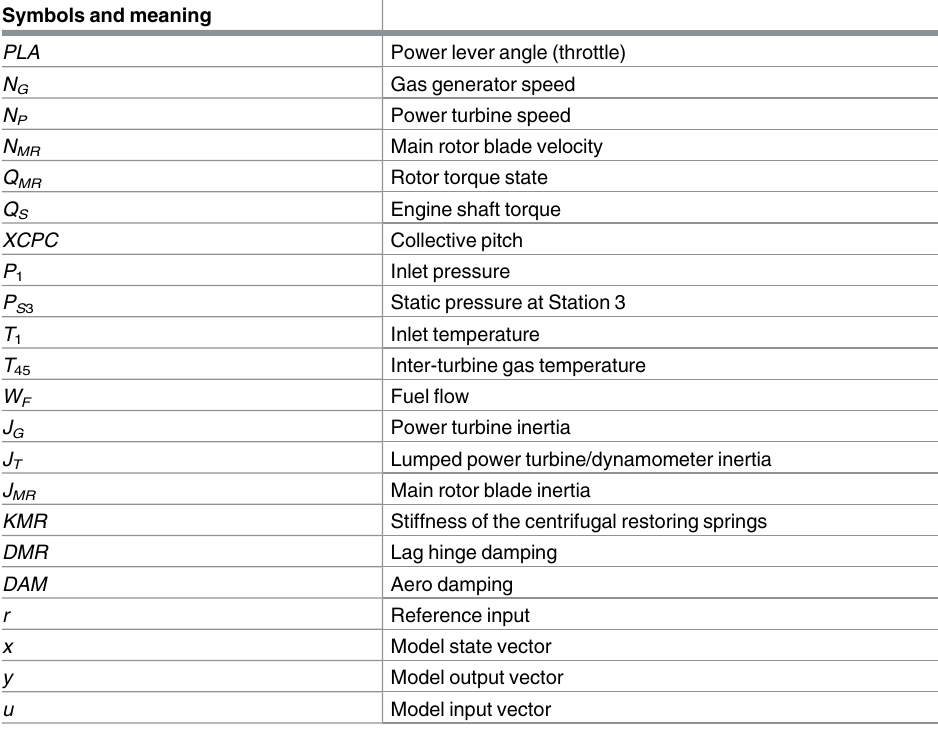
Table 1. Symbols of the GE T700 turboshaft